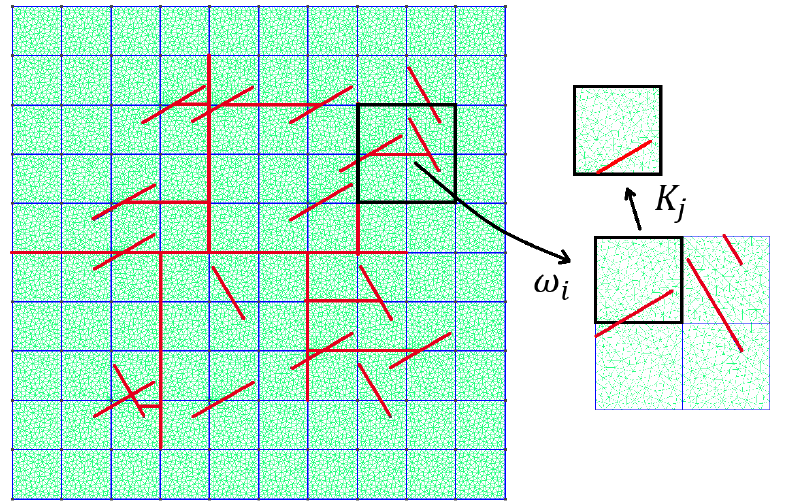
Figure 1. Coarse grid and local domain ω l with K j